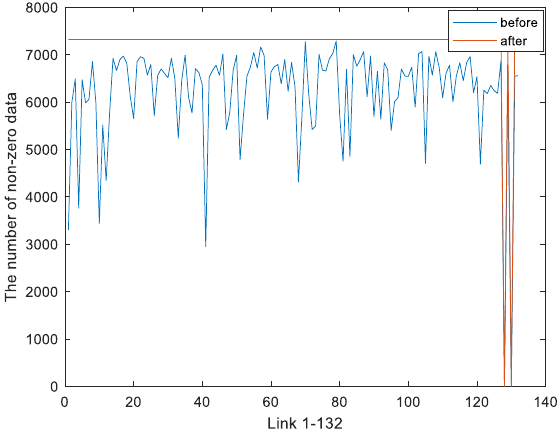
Figure 7. Missing data completion rate.